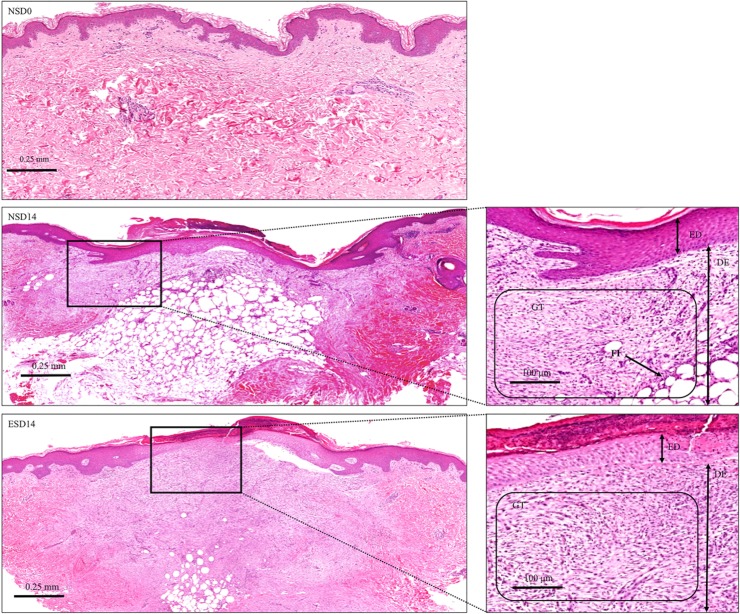
Hematoxylin and Eosin staining (normal skin and healing day 14).Hematoxylin and Eosin staining on days 0 (NSD0 or normal skin) and 14 of normal healing tissues (NSD14) and ES treated healing tissues (ESD14). ES samples showed a similar phenotype to normal skin with better wound bed re-organisation and accelerated granulation tissue stage development. ED is epidermis, DE is dermis, GT is granulation tissue, FT is fat/adipose tissue.